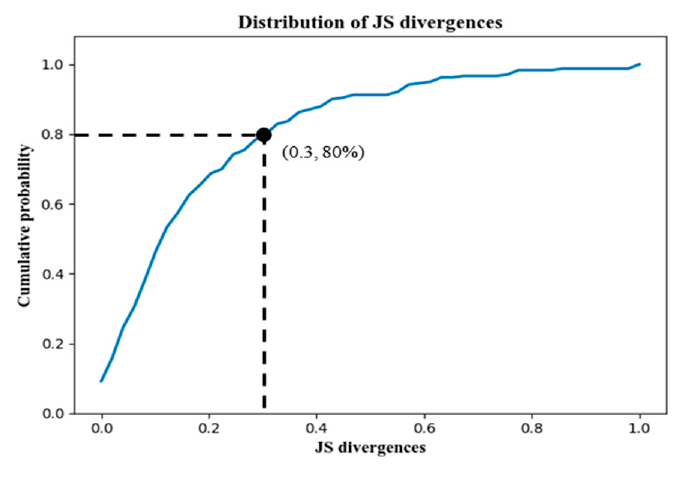
Figure 22. The CDF of JS (cid:4672)R(cid:3435)𝑆𝑒𝑞 (cid:3036)(cid:3041)(cid:3033)(cid:3032)(cid:3045)(cid:3007) (cid:3439)||R(𝑆𝑒𝑞 (cid:3047)(cid:3045)(cid:3048)(cid:3032)(cid:3007) )(cid:4673). In general, the current inferring errors of APs have a small influence on AP map- matching and trajectory